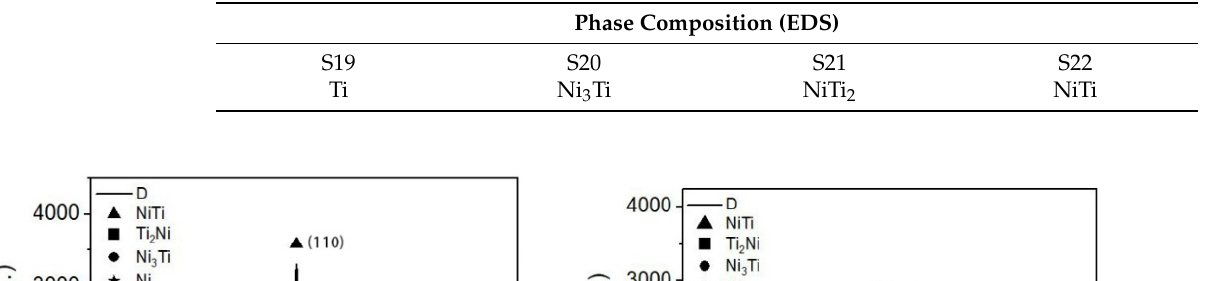
Figure 12. X-ray diffractograms of 3D object from filament D ( a ) top, ( b ) bottom. Considering that during sintering the 3D objects are on a platform that could compromise the process and originate the formation of new phases, both the top and base were analyzed by XRD. It is clear that the top and base of 3D objects show similar phase composition, meaning that all binder and additives were effectively removed, and the sintered phases are similar. Tomography analysis is of enormous importance to detect failures inside the green and sintered 3D objects. For some compositions, detailed analysis of filaments defects before and after debinding and sintering reveals a significant presence of porosity, inside and at the surface. The defects are mainly present in filament D. Filaments A, B, and C,